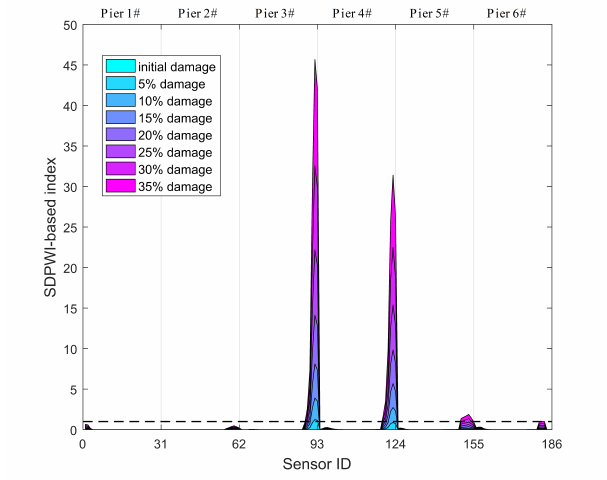
Figure 13. Identification results of Damage II for all six piers using warning